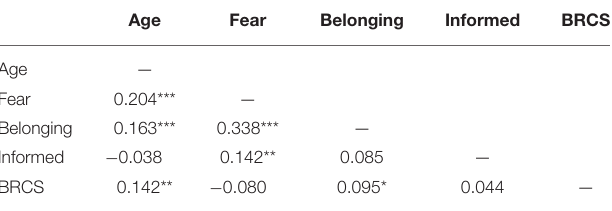
TABLE 3 | Pearson Correlations on the variables of interest for the whole dataset.